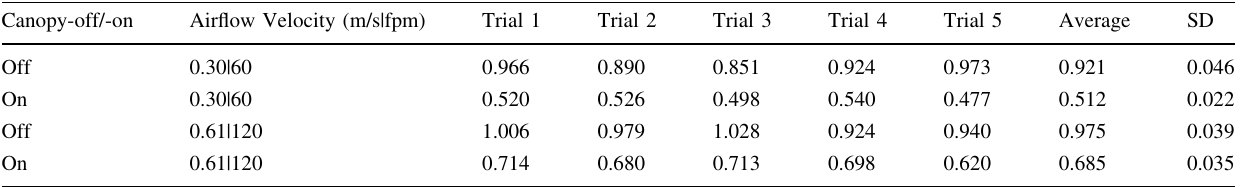
Table 8 Ratios calculated for the CAC at 10-in. height underneath the canopy using Small Fan #1 Canopy-off/-on